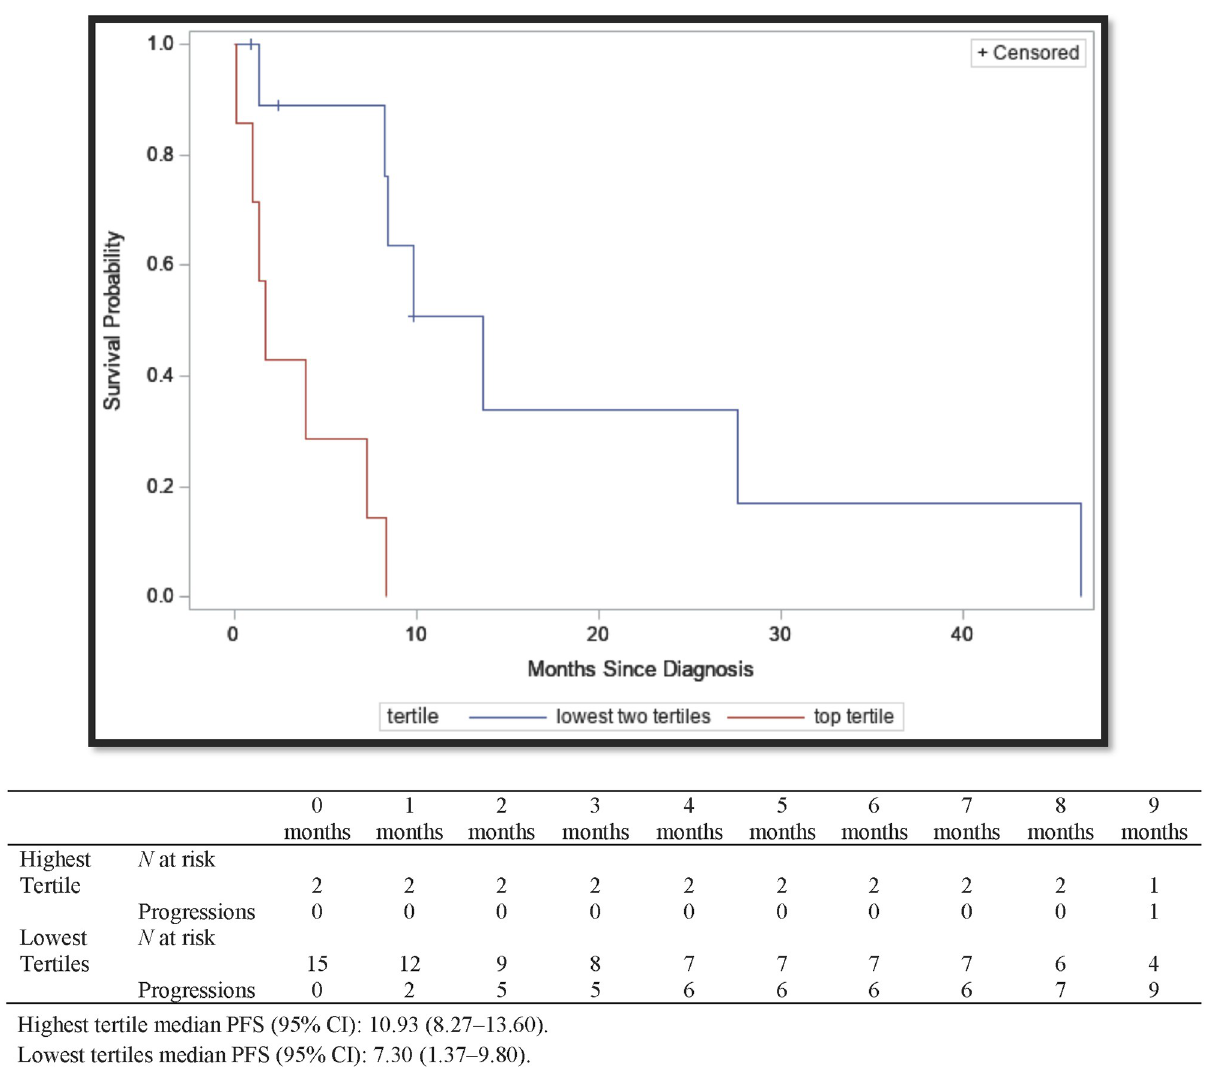
Fig 4. Kaplan-Meier survival curves for progression-free survival of MIBC by highest tertile of IFN- γ signature vs the lowest two tertiles. Mt Sinai hospital system and North Shore Long Island Jewish health system, New York, New York. 2004–2017. Highest tertile median PFS (95% CI): 10.93 (8.27–13.60). Lowest tertiles median PFS (95% CI): 7.30